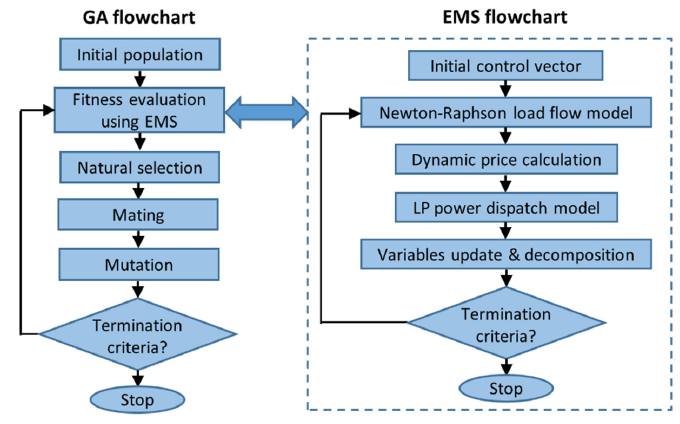
Figure 2. Flowchart of the proposed optimization framework.